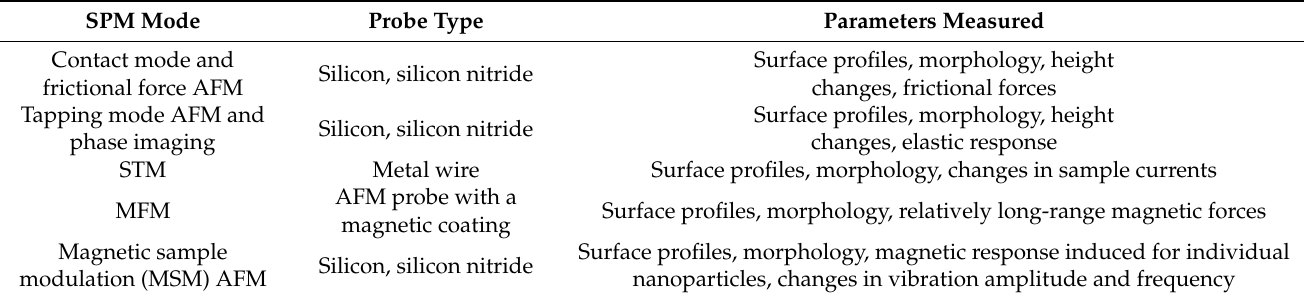
Table 1. Most common SPM imaging modes applied for characterizing nanoparticles. SPM Mode Probe Type Parameters Measured Surface profiles, morphology, height Contact mode and Silicon, silicon nitride changes, frictional forces frictional force AFM Surface profiles, morphology, height Silicon, silicon nitride changes, elastic response Metal wire Surface profiles, morphology, changes in sample